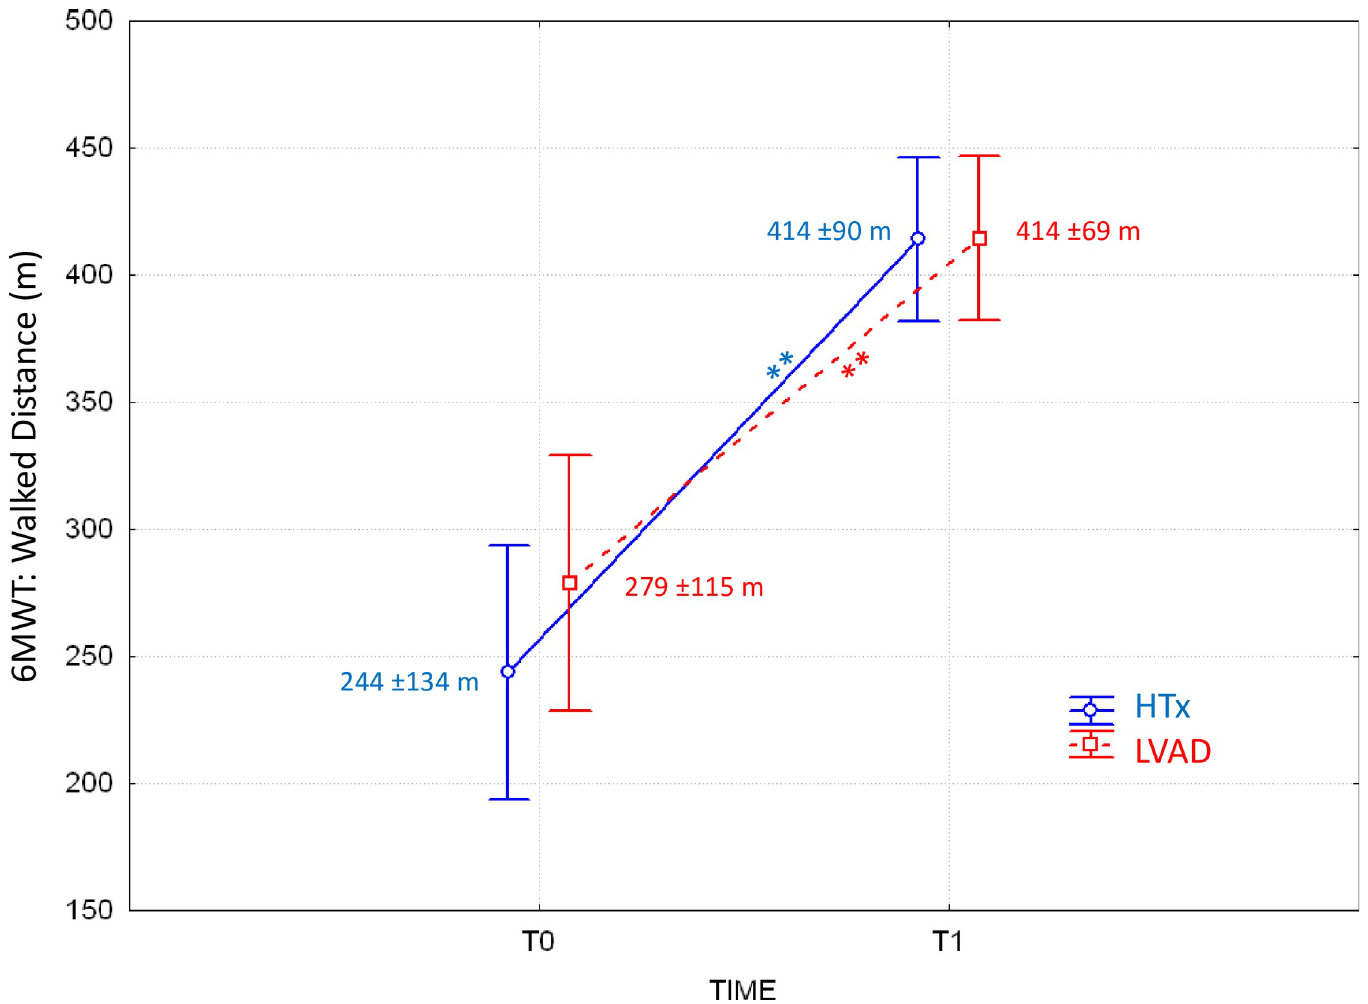
Fig 2. Distance walked during the six-minute walk test (6MWT) in patients who received the implant of a left ventricle assist device (LVAD, N = 25) or heart transplant (HTx, N = 25) at the start (T0) and end (T1) of the cardiac rehabilitation program. Values as mean ± SD; the �� indicate significant differences between T0 and T1 at p < 0.01 (Fisher’s LSD post-hoc analysis after repeated measures